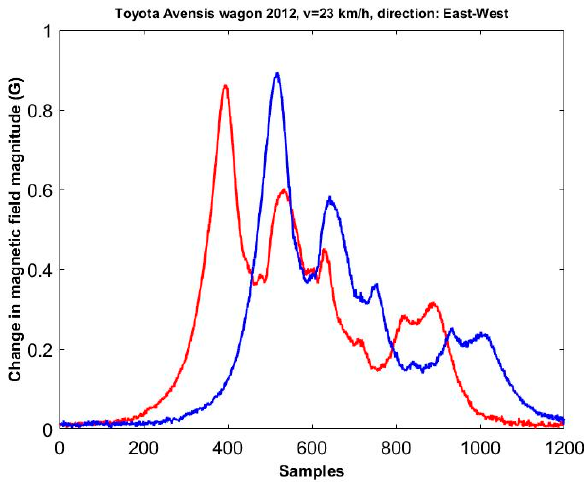
Figure 2. The changes in the magnetic field magnitude caused by Toyota Avensis that passed in the centre of a road line.